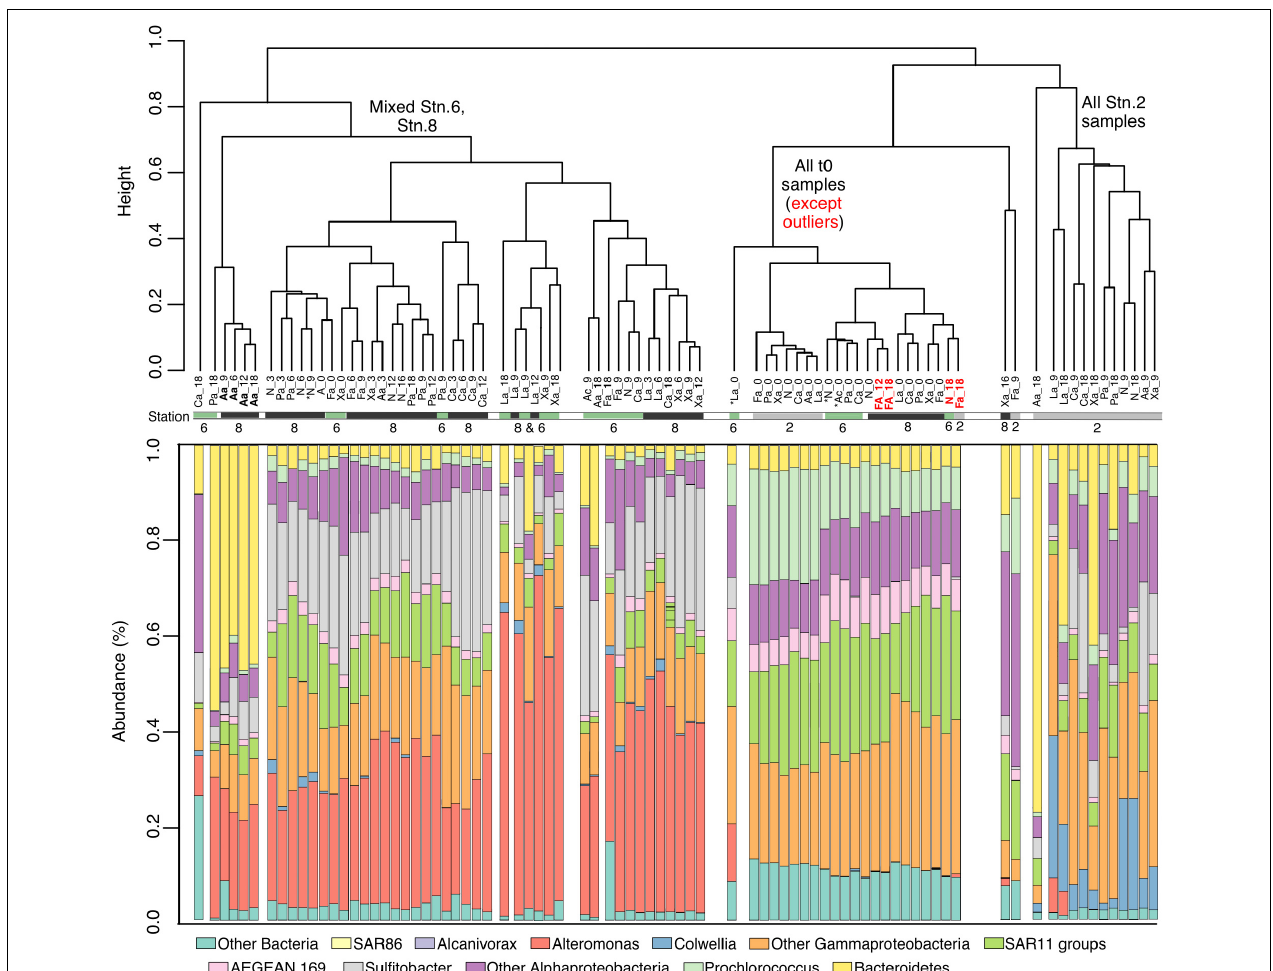
FIGURE 4 | Dendrogram showing the similarity clustering of microbial community compositions between samples from different stations, incubations, and time points. Bar charts underneath the dendrogram shows relative community composition of each incubation and time point. ∗ indicates samples with < 10,000 reads. Abbreviations under dendrogram branches indicate substrate and incubation timepoint (e.g., La_9 indicates laminarin incubation at 9